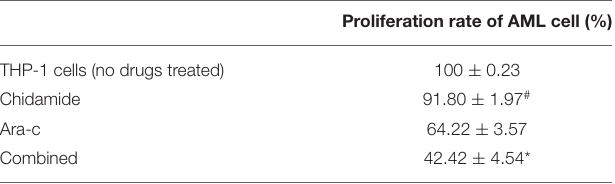
TABLE 1 | The change in the proliferation of THP-1 cell lines treated by chidamide, Ara-c, and Ara-c combined with chidamide for 24h.